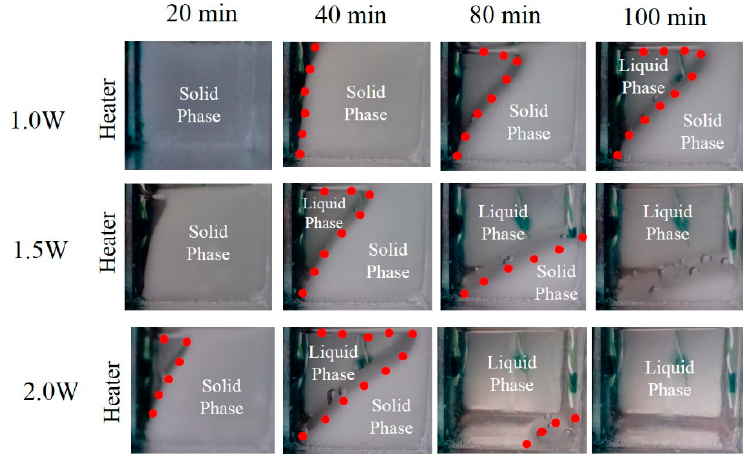
Figure 5. Images of RT47 melting profile for different power rating and time.